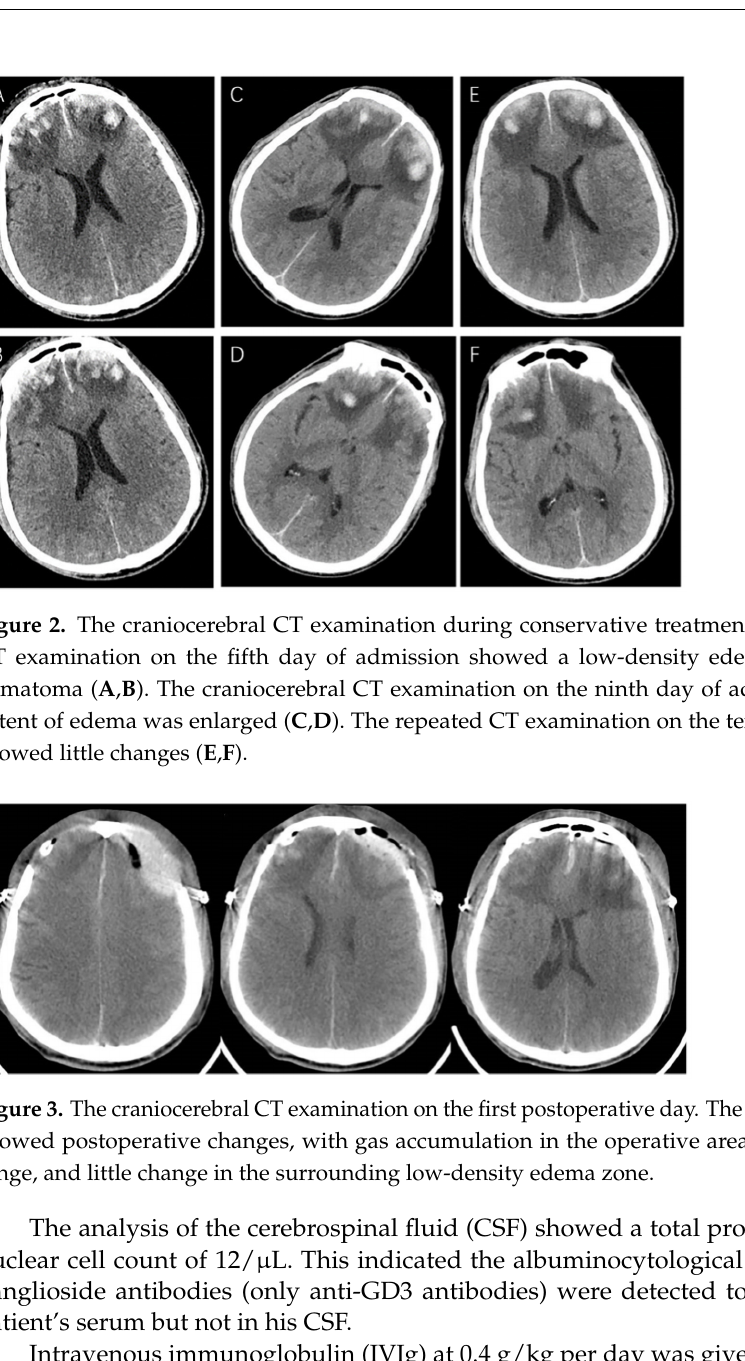
Figure 2. The craniocerebral CT examination during conservative treatment. The craniocerebral CT examination on the fifth day of admission showed a low-density edema zone around the hematoma ( A , B ). The craniocerebral CT examination on the ninth day of admission showed the extent of edema was enlarged ( C , D ). The repeated CT examination on the tenth day of admission showed little changes ( E , F ).